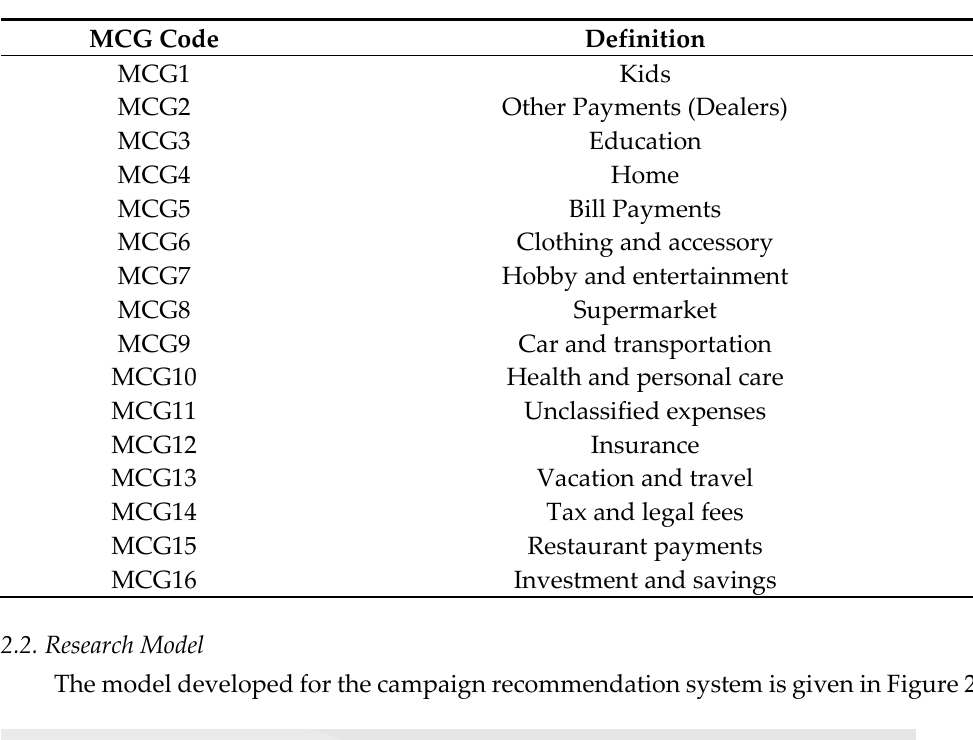
Table 1. Definition of MCG .